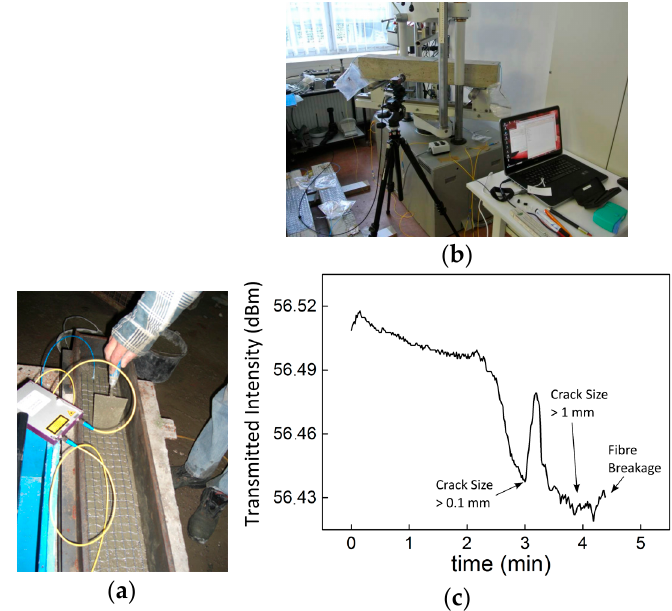
Figure 3. Embedding the sensor in a concrete block ( a ) and experimental set-up ( b ) for the evaluation of the fiber optic crack sensor performance ( c